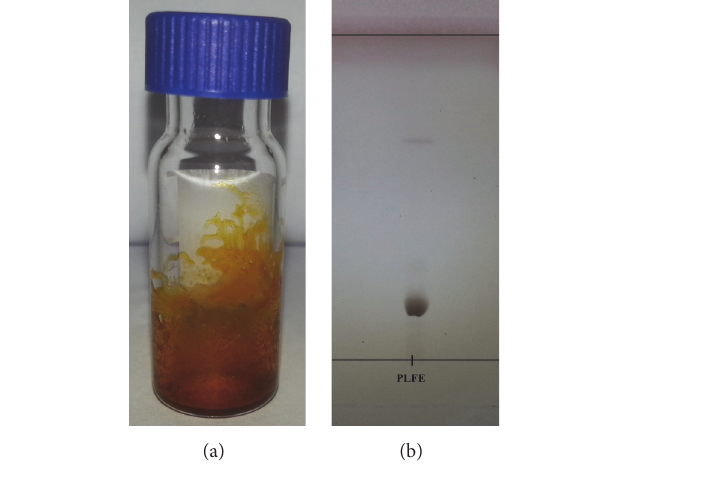
Figure 3: (a) Appearance of purified PLFE (19.6 mg). (b) HPTLC of PLFE with CHCl 3 : MeOH : H 2 O (70 :26:4v/v) as a mobile phase and silica gel as a stationary